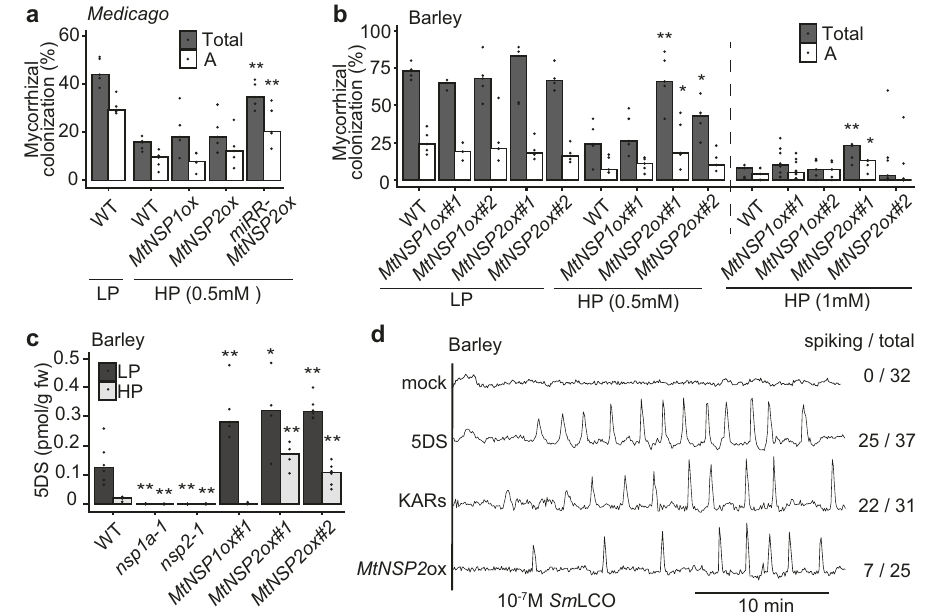
Fig. 4 | Overexpression of NSP2 promotes AMF colonization and strigolactone biosynthesis. a AMF colonization measured at 5 weeks post-inoculation in M. truncatula roots overexpressing MtNSP1 , MtNSP2, and a miR171h-resistant version of NSP2 ( miRR-MtNSP2 ), grown under high P (HP) conditions, with wild-type (WT) under low P (LP) and HP conditions as controls. WT indicates roots transformed with an empty vector. n =5 biologically independent samples. b Root-length colonizationat7weekspost-inoculationinbarleyrootsoverexpressing MtNSP1 and MtNSP2 grown under different P levels. n =3 – 5 biologically independent plants. c Strigolactone levels in barley nsp mutants and NSP overexpression lines under